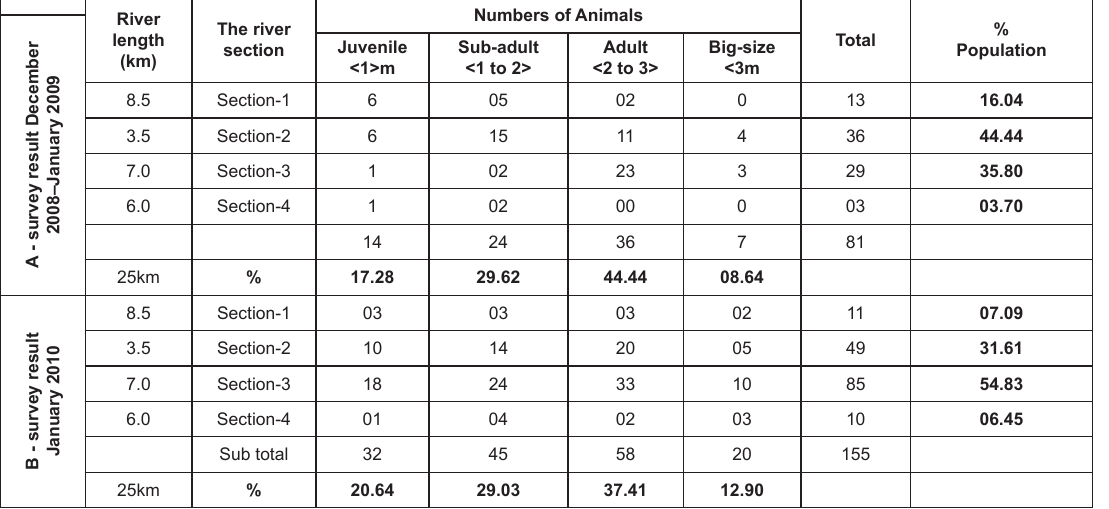
Table 1. The Vishwamitri River section and count of Mugger Crocodylus palustris